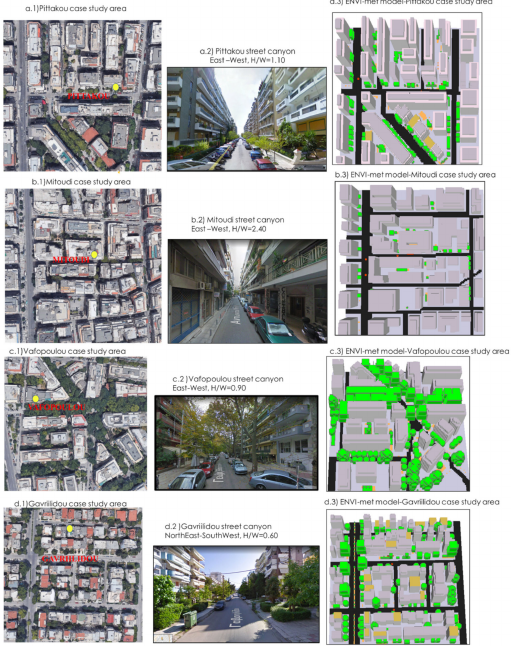
Figure 2. Google Earth images of the selected urban districts and indication of the onsite measure- ments spot ( a.1 – d.1 ), cross-section of the street canyons where the building units, the energy needs of which are to be assessed, are located and an indication of their orientation and H/W ratio ( a.2 – d.2 ) and the 3D ENVI-met area input files of the case study areas ( a.3 – d.3